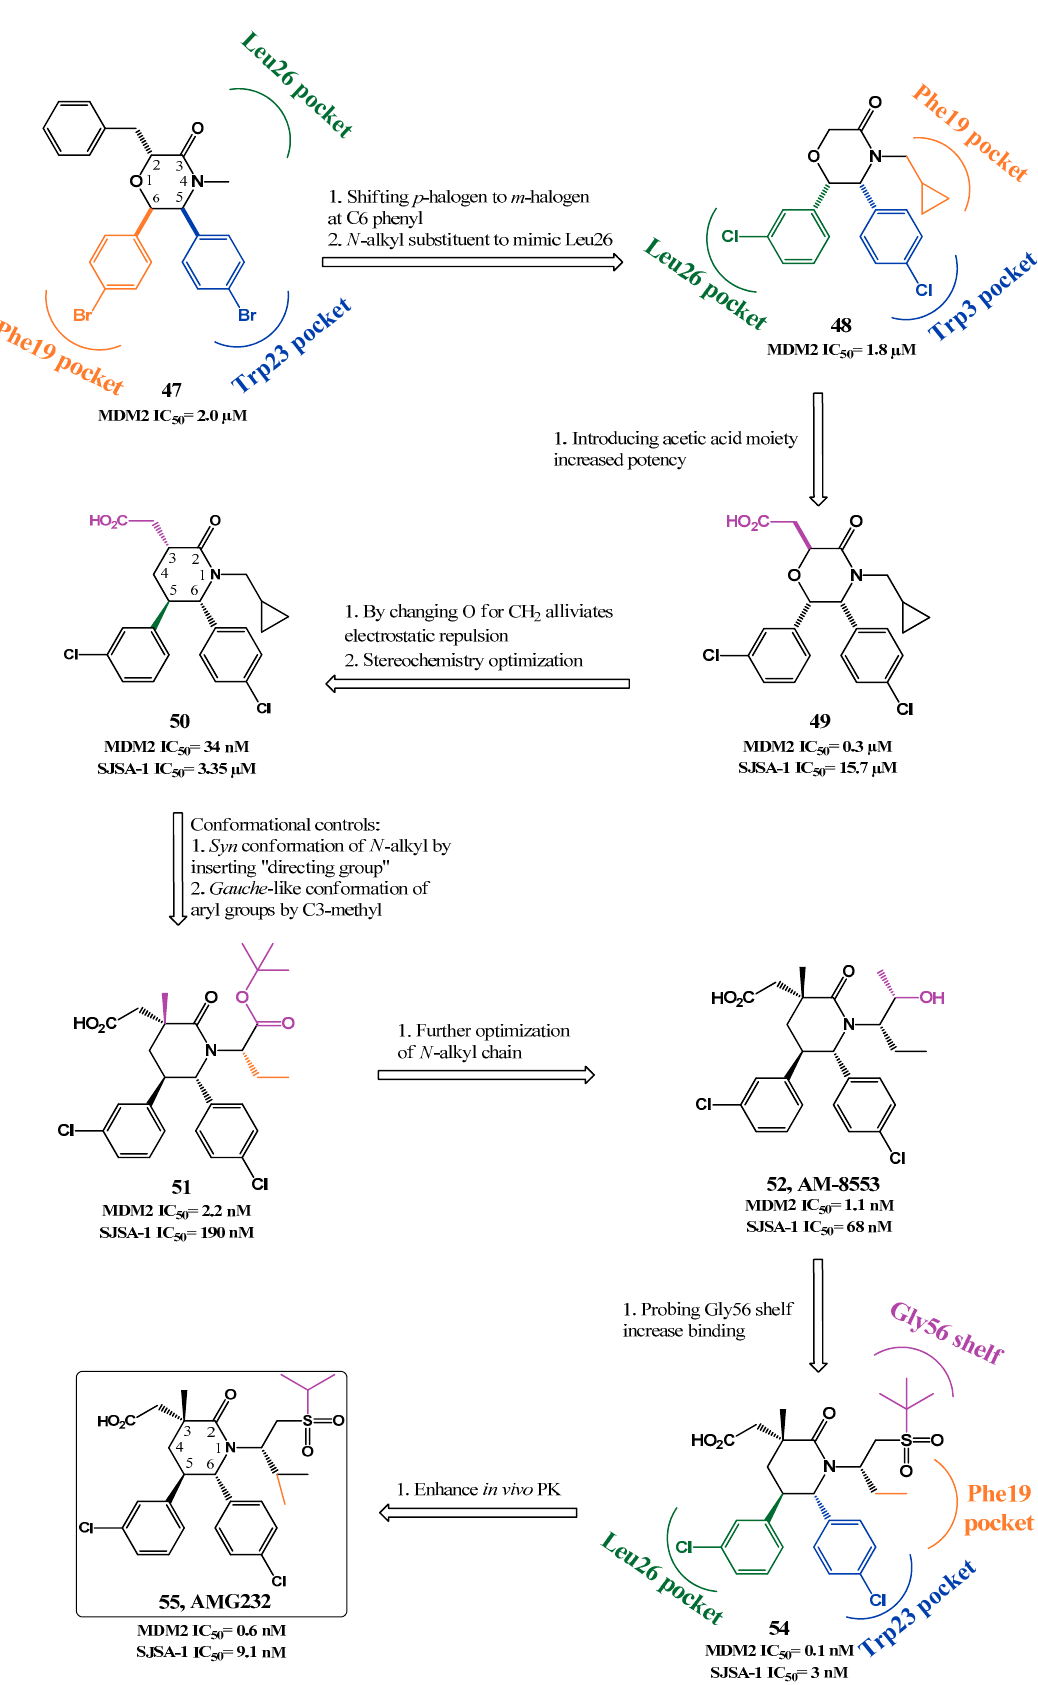
Figure 13. Piperidinone scaffold optimization to AMG232.